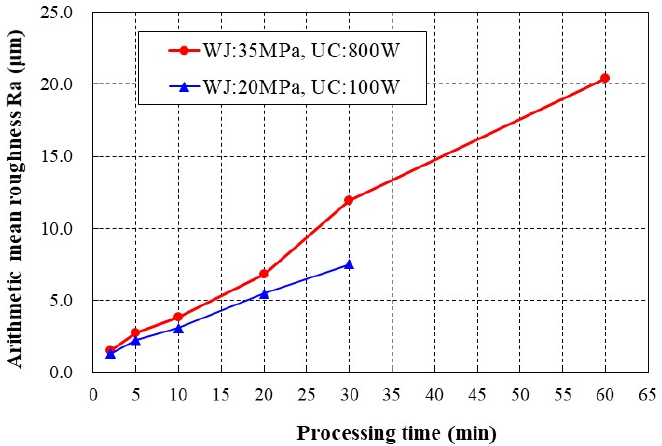
Figure 5. Change of surface roughness with processing time of LPTC and UTPC (LTPC: jet 20 MPa, UC 100 W; UTPC: jet 35 MPa, UC 800 W) (Evaluation length 5 mm)